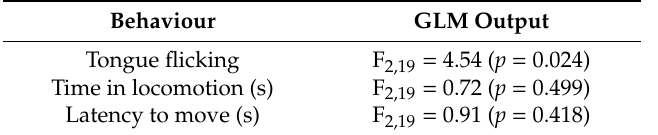
Table 1. Results of general linear model analysis to test the effect of handling condition as a fixed factor on behaviour in the novel environment test.